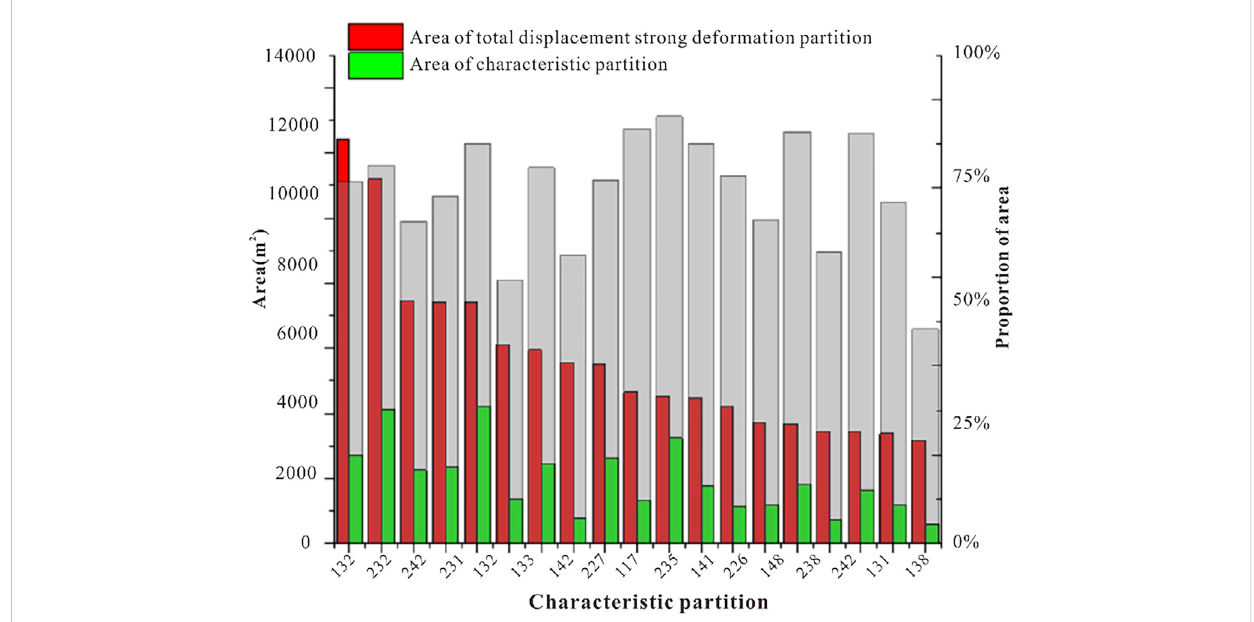
FIGURE 16 The ratio of the area of strong deformation of total displacement and its characteristic